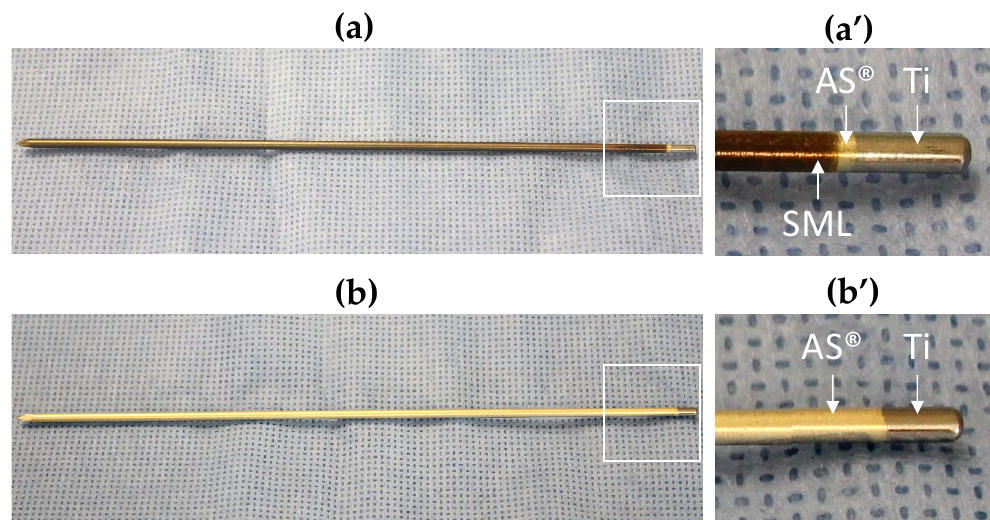
Figure 1. ( a ) Test item: SML-coated AS ® /titanium K-wire, ( a’ ) shows the two coatings in magnification. SML = bronze, AS ® = golden. ( b ) Blank item: AS ® -coated titanium K-wire, ( b’ ) shows the AS ® coating in magnification. The silver color at the blunt end of each K-wire shows the uncoated titanium surface. SML Coating